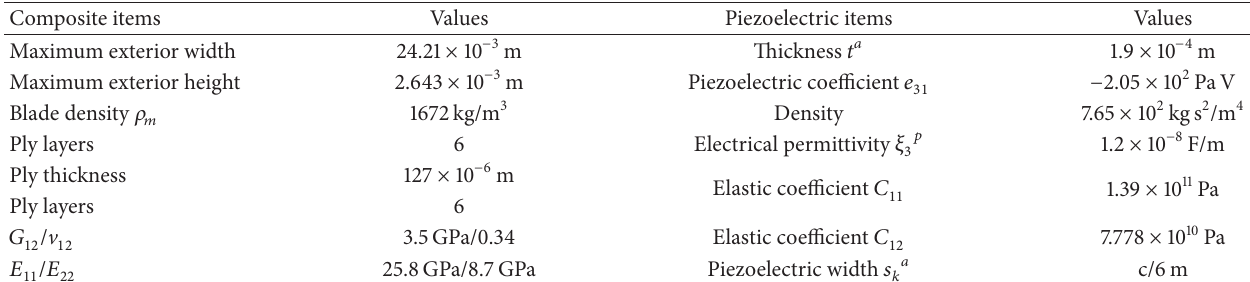
Table 1: Composite parameters and piezoelectric